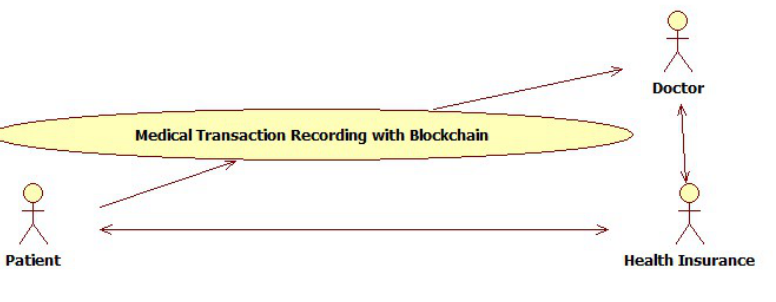
Figure 1. Use case diagram for data flow